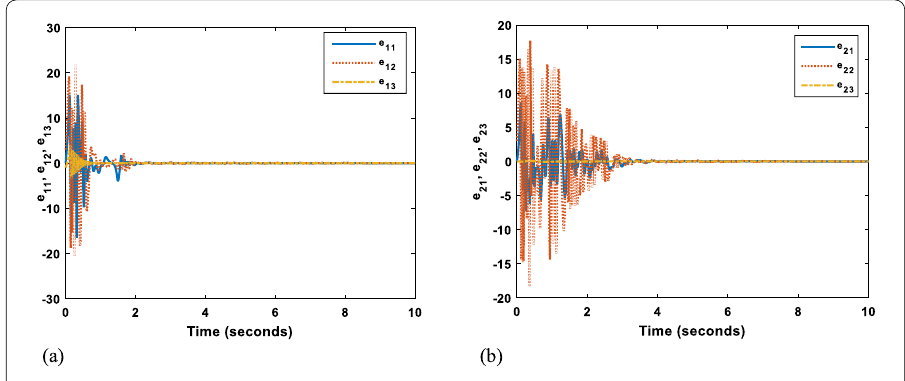
Figure 2 State trajectories of the error system: ( a ) e 11 ( t ), e 12 ( t ), e 13 ( t ) and ( b ) e 21 ( t ), e 22 ( t ), e 23 ( t